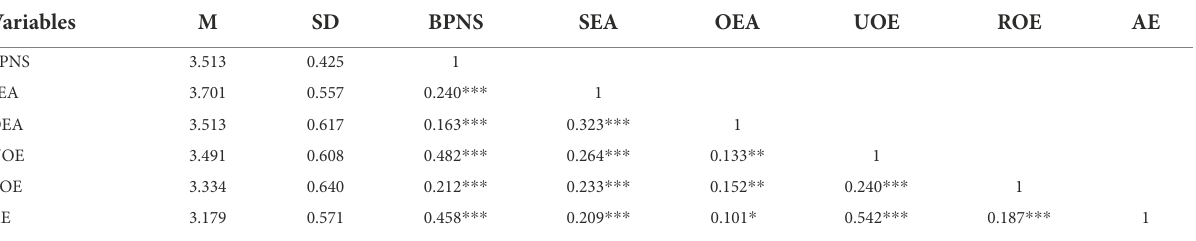
TABLE 3 Descriptive statistics and correlations among the study